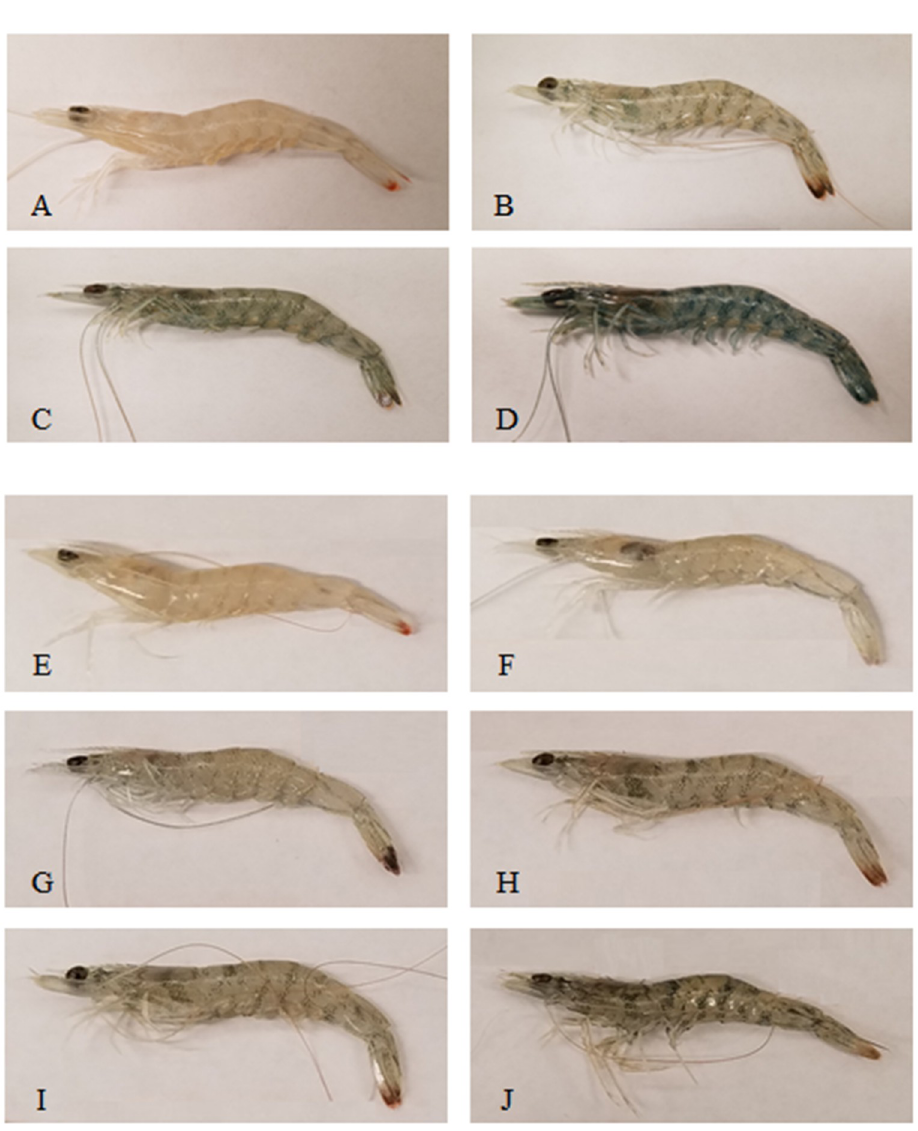
imidacloprid, ( F ) 0.5 μ g/L imidacloprid, ( G ) 1.0 μ g/L imidacloprid, ( H ) 15.0 μ g/L imidacloprid, ( I ) 34.5 μ g/L imidacloprid, ( J ) 320.0 μ g/L imidacloprid.